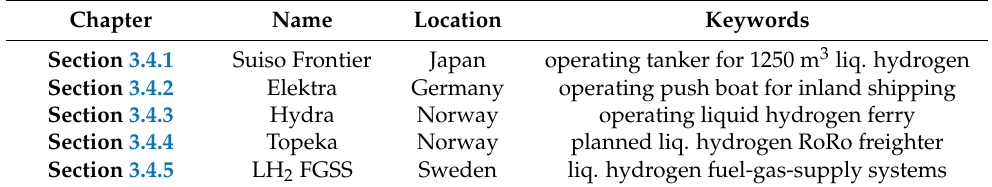
Table 2. Overview of different hydrogen